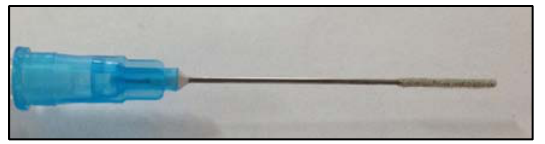
Figure 2. Laboratory ‐ made SPME fiber. SPME solid–phase microextraction.